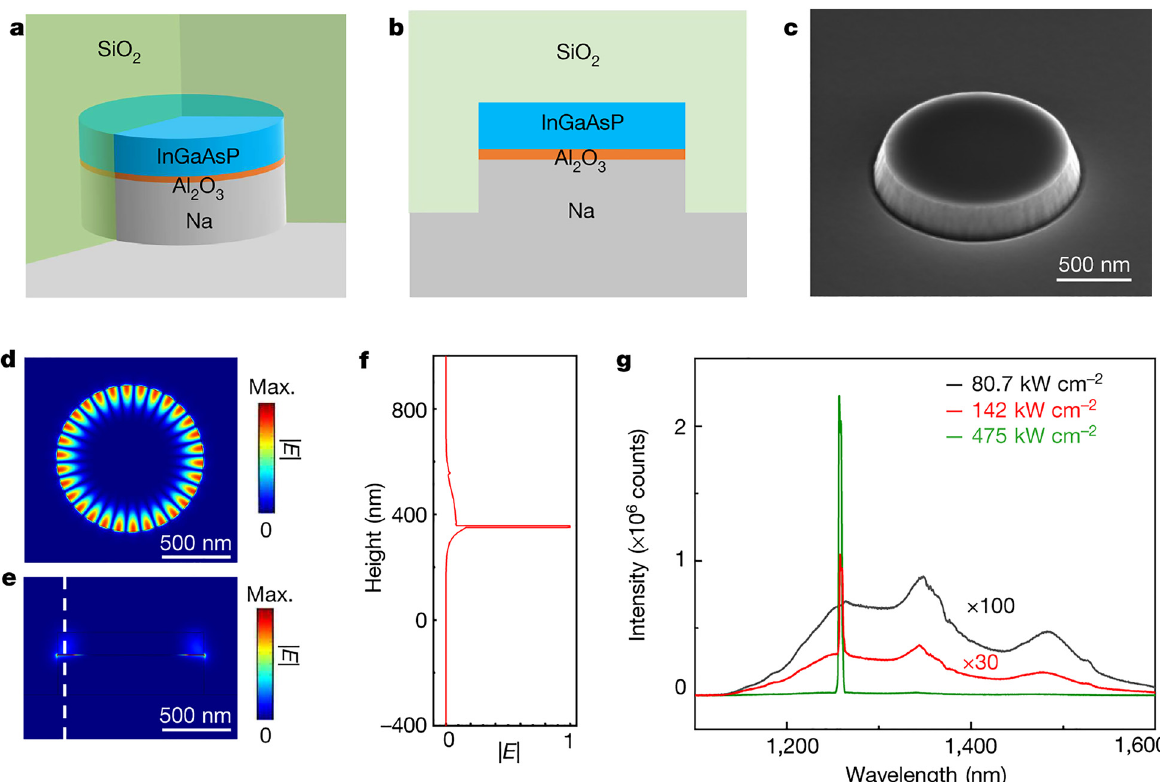
Figure 5: Room-temperature sodium-based plasmonic nanolaser. a – b , Schematics of a sodium-based plasmonic nanolaser in three dimensions ( a ) and two dimensions ( b ). c , SEM image of an InGaAsP MQWs nanodisk without sodium coating. d – e , Top (d) and side (e) views of the electric- fi eld intensity distribution of the calculated lasing mode. f , Normalized electric- fi eld intensity pro fi le along the white dashed line in (e). g , Spectra of spontaneous emission (black), ampli fi ed spontaneous emission (red), and single-mode laser emission (green) of the sodium-based plasmonic nanolaser. Figure adapted